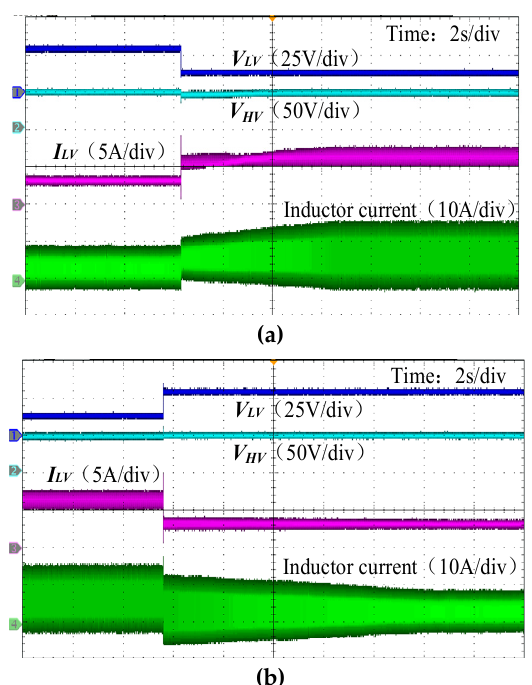
Figure 17. Experimental ZVS waveforms with ( a ) V LV = 32 V step to 16 V step; ( b ) V LV = 16 V step to 32 V step.